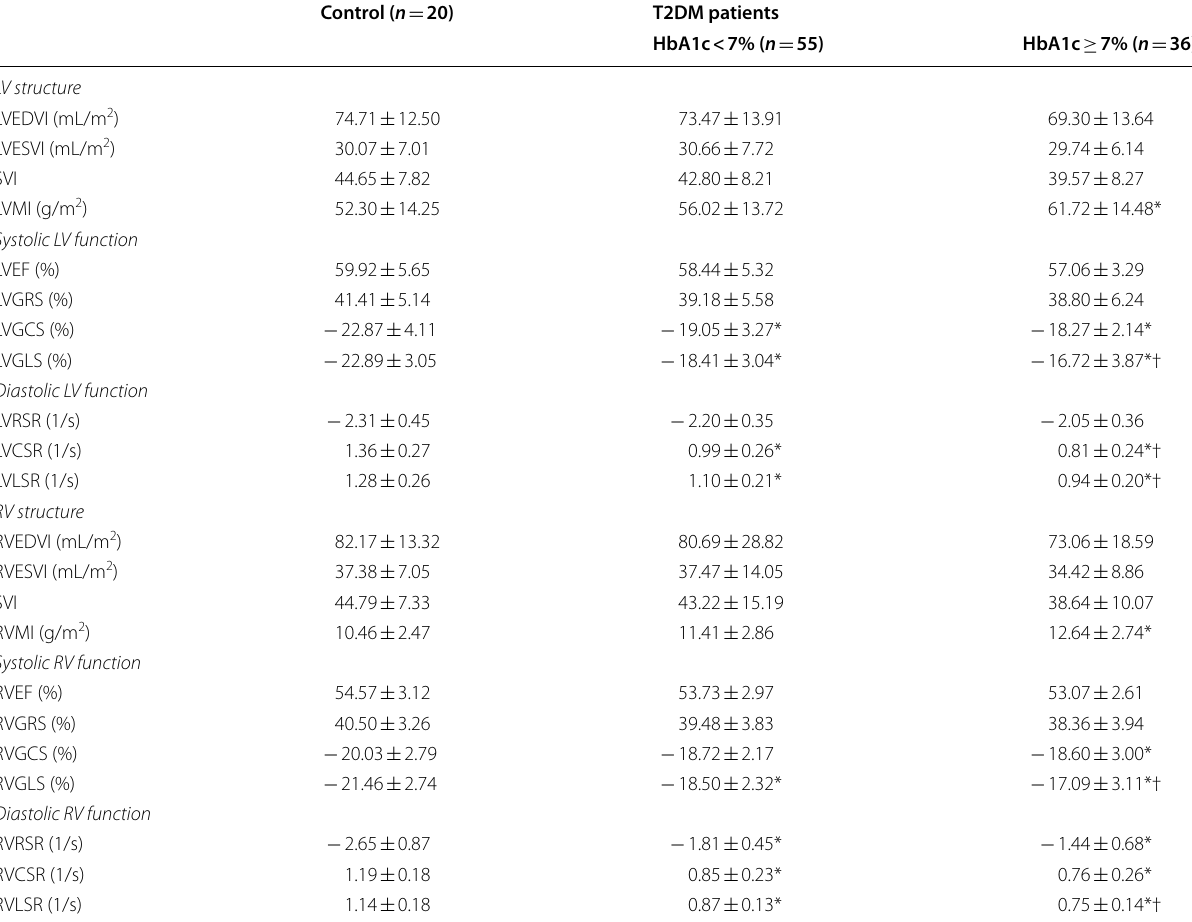
LV left ventricular, RV right ventricular, EDVI end-diastolic volume index, ESVI end-systolic volume index, SVI stroke volume index, MI mass index, EF ejection fraction, GRS global peak systolic radial strain, GCS global peak systolic circumferential strain, GLS global peak systolic longitudinal strain, RSR peak diastolic radial strain rate, CSR peak diastolic circumferential strain rate, LSR peak diastolic longitudinal strain rate * p value < 0.05 when compared with the controls group † p value < 0.05 when compared with the patients with HbA1c <